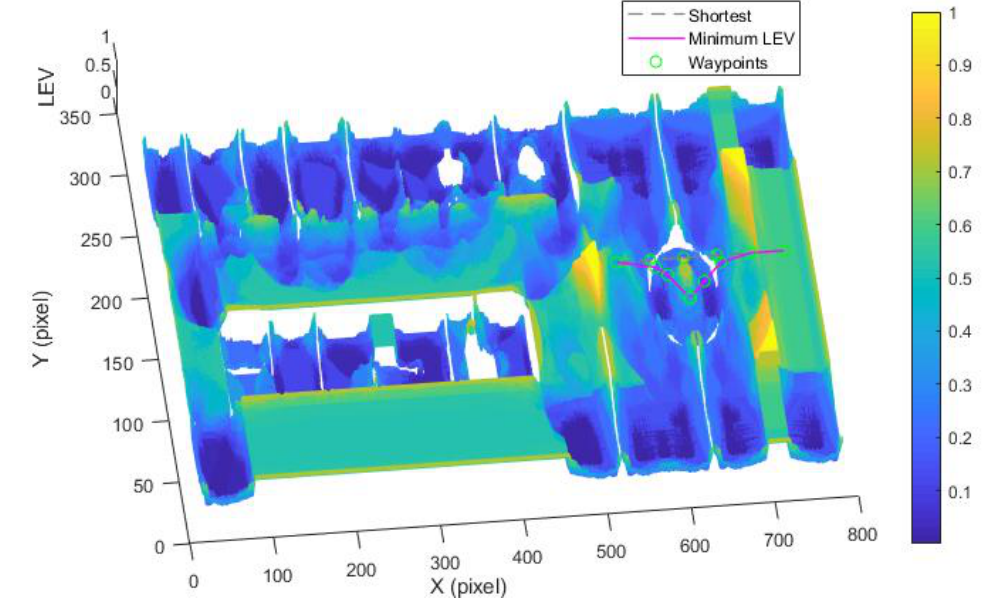
Figure 16. Optimal trajectory based on minimum localization error in the circle region.